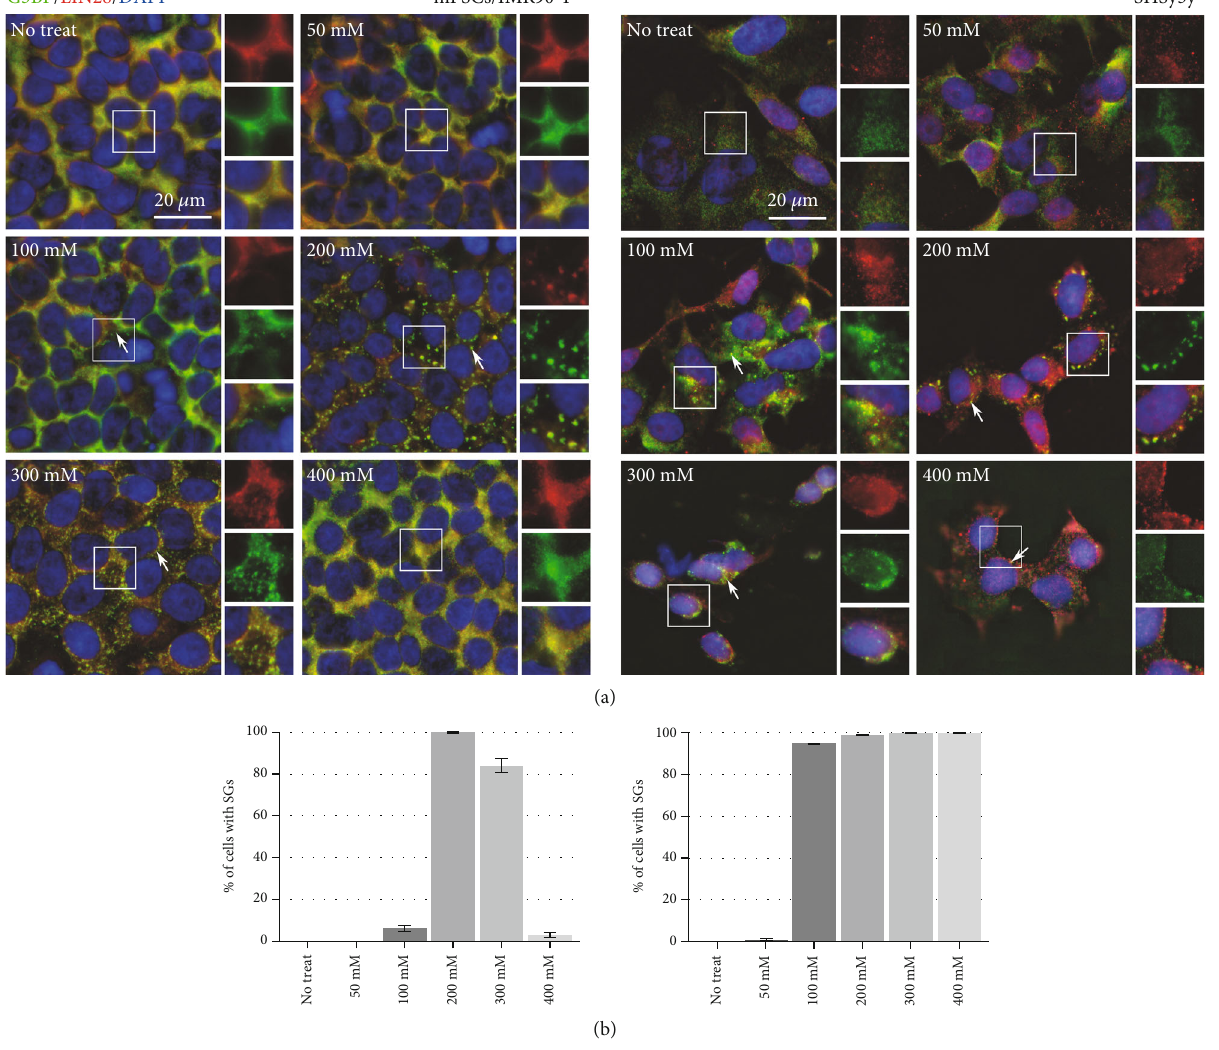
Figure 1: SG assembly in hiPSCs/IMR90-1 and SH-SY5Y under hyperosmolarity stress. (a) Representative fl uorescence microscopy images showing nontreated hiPSCs/IMR90-1 and SH-SY5Y cells treated with 50, 100, 200, 300, and 400 mM of sodium chloride stained with the robust SG marker (G3BP (green)). LIN28 is an RNA-binding protein involved in promoting pluripotency. Nucleus is stained in blue (Hoechst). Insets show magni fi ed views of SGs. White arrows indicate SGs. Scale bar indicates 20 μ m. (b) Percentage of hiPSCs/IMR90-1 with G3BP-positive SGs after 1h treatment with the indicated concentrations of sodium chloride (50, 100, 200, 300, and 400mM). The average percentage of cells with SGs is shown. Error bars indicate the ± standard deviation from 3 independent experiments. Approximately, 1000 cells were counted (distributed over 20 di ff erent fi elds within each